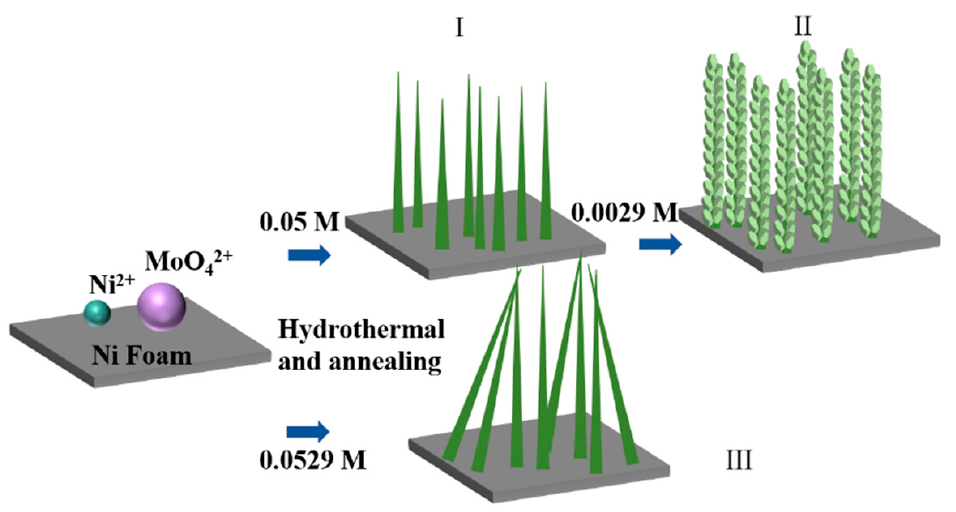
Figure 3. Illustration of the growth mechanism of Samples I, II, and III.